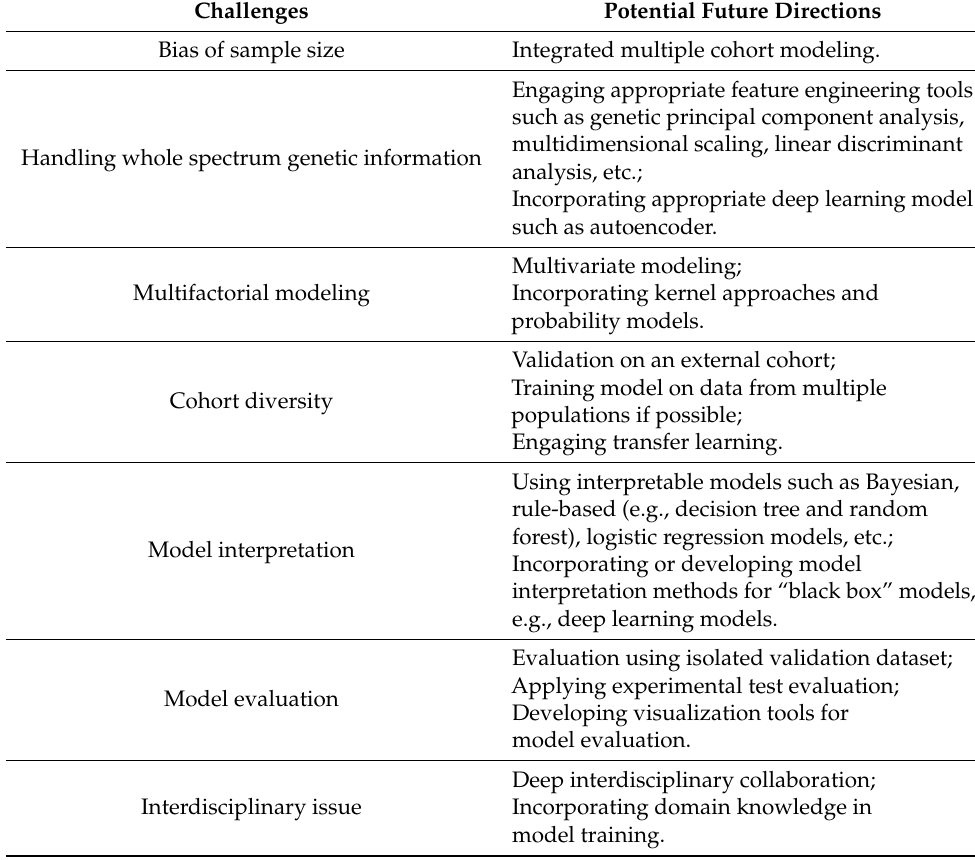
Table 5. Summary points of challenges and potential future directions to address them